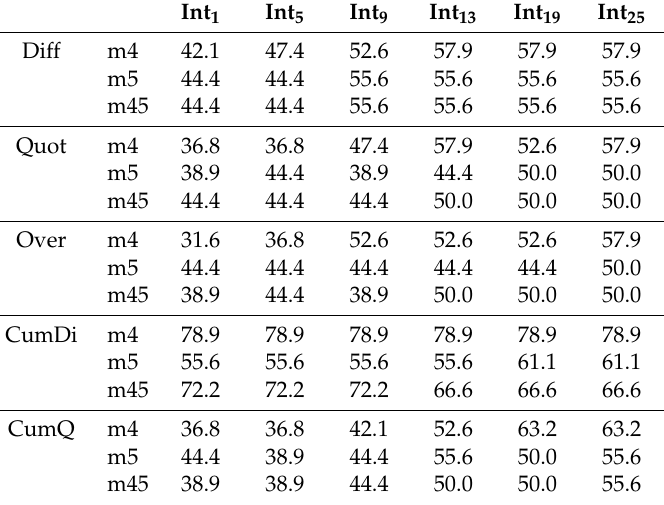
Table 2. Maximal detection rate (%) for the onset of farrowing within 12 h before the onset of farrowing (first alarm for each sow) per type of acceleration index (Diff, . . . , CumQ), parameterization period (m4: Day − 4, m5: Day − 5, m45 = Days − 4 and − 5), and interval length of the moving average (Int x , x = ± 1,5,9,13,19,25) for the distribution characteristic 1st variation and 10 min period independent of the k and h